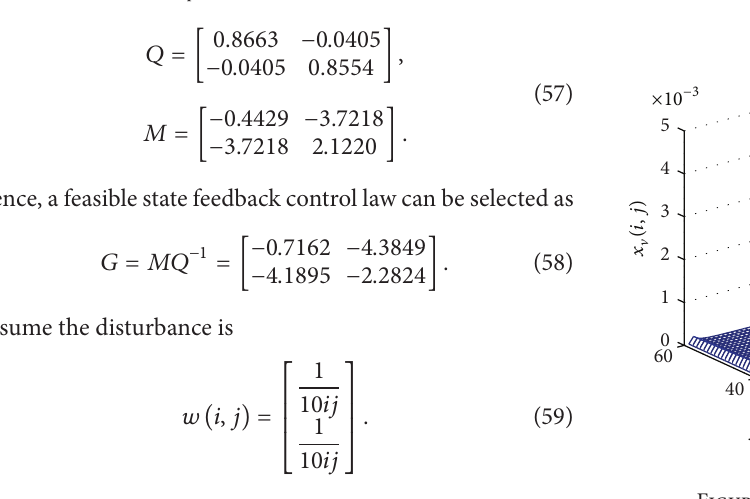
Figure 1: State response of 𝑥 ℎ (𝑖,𝑗) for Example 1.